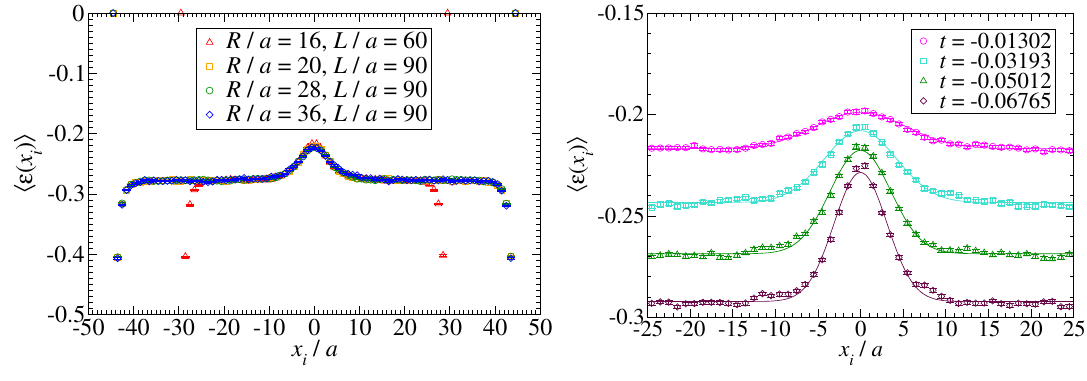
Figure 5 . Left-hand-side panel: average energy density h ε i along the main spatial axes through the edges of a cube at the center of the lattice, as a function of the x i coordinate, in units of the lattice spacing, in the presence of a topological excitation in the broken-symmetry phase, as obtained from simulations at t = − 0 . 05604 . Right-hand-side panel: dependence of h ε ( x i ) i on the reduced temperature, as evaluated from numerical simulations on lattices with Euclidean-time extent R = 20 a and spatial volume L 3 = (90 a ) 3 . The solid curves are obtained from fits to eq. (3.6), which was derived in ref.